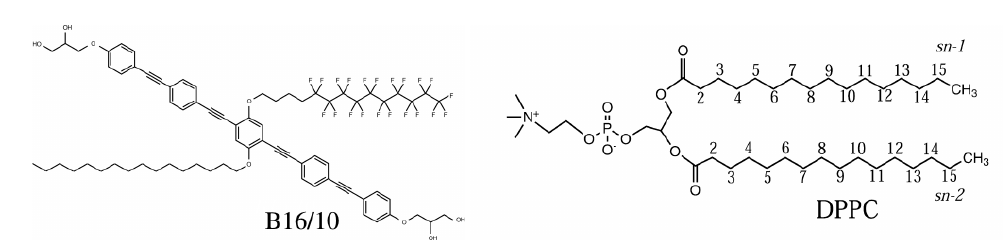
Figure 7. Chemical structure of the polyphilic molecule B16/10 and dipalmitoylphosphatidylcholine (DPPC) molecule considered in this